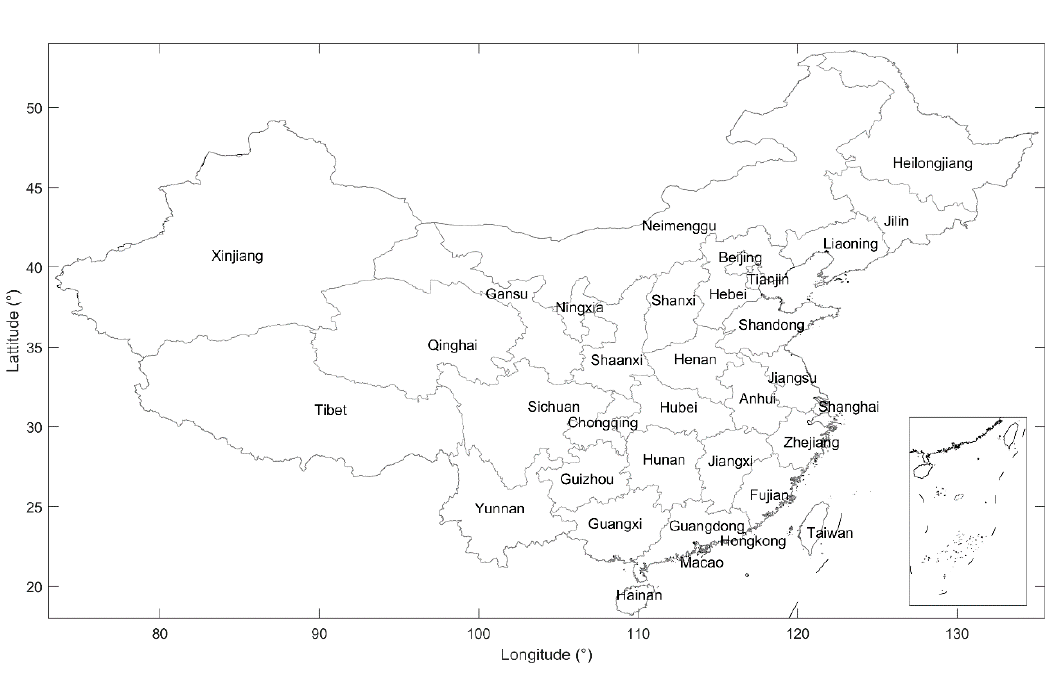
Figure A1. The location map of different provinces in China.